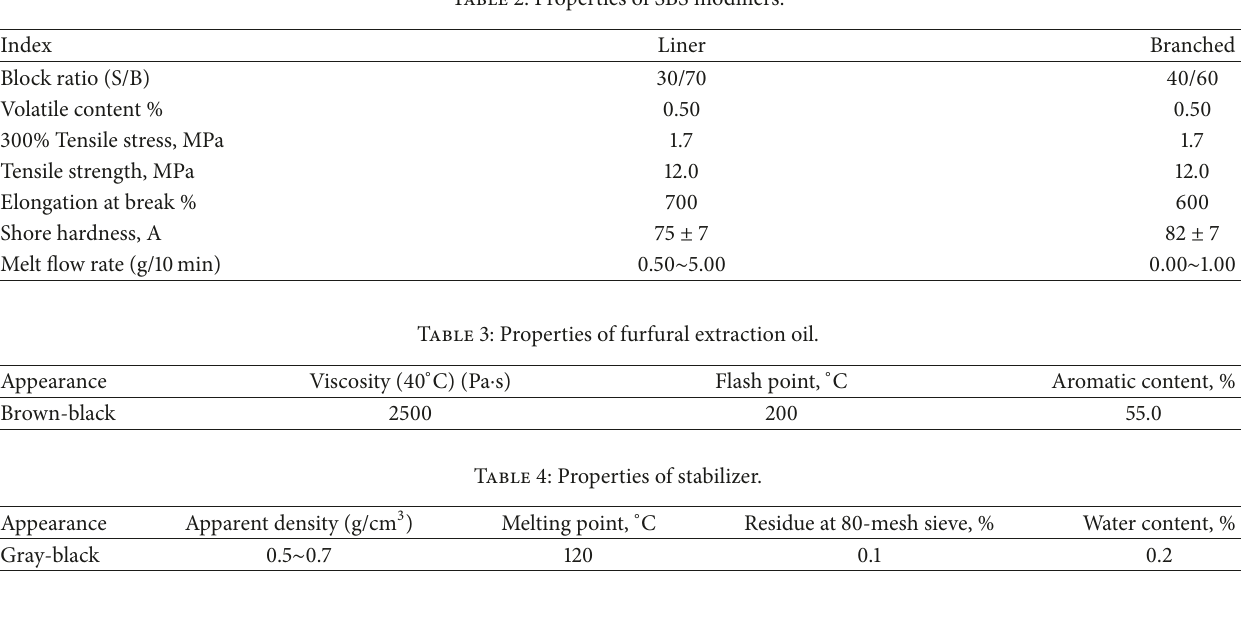
Table 2: Properties of SBS modifiers.